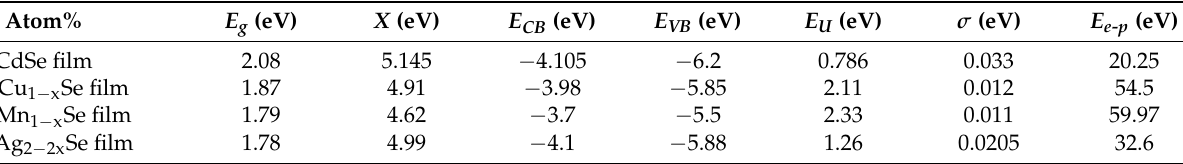
Table 1. E g , CB , and VB were estimated by Tauc equation and the band tail, σ , E e-p were obtained from the absorption spectra.